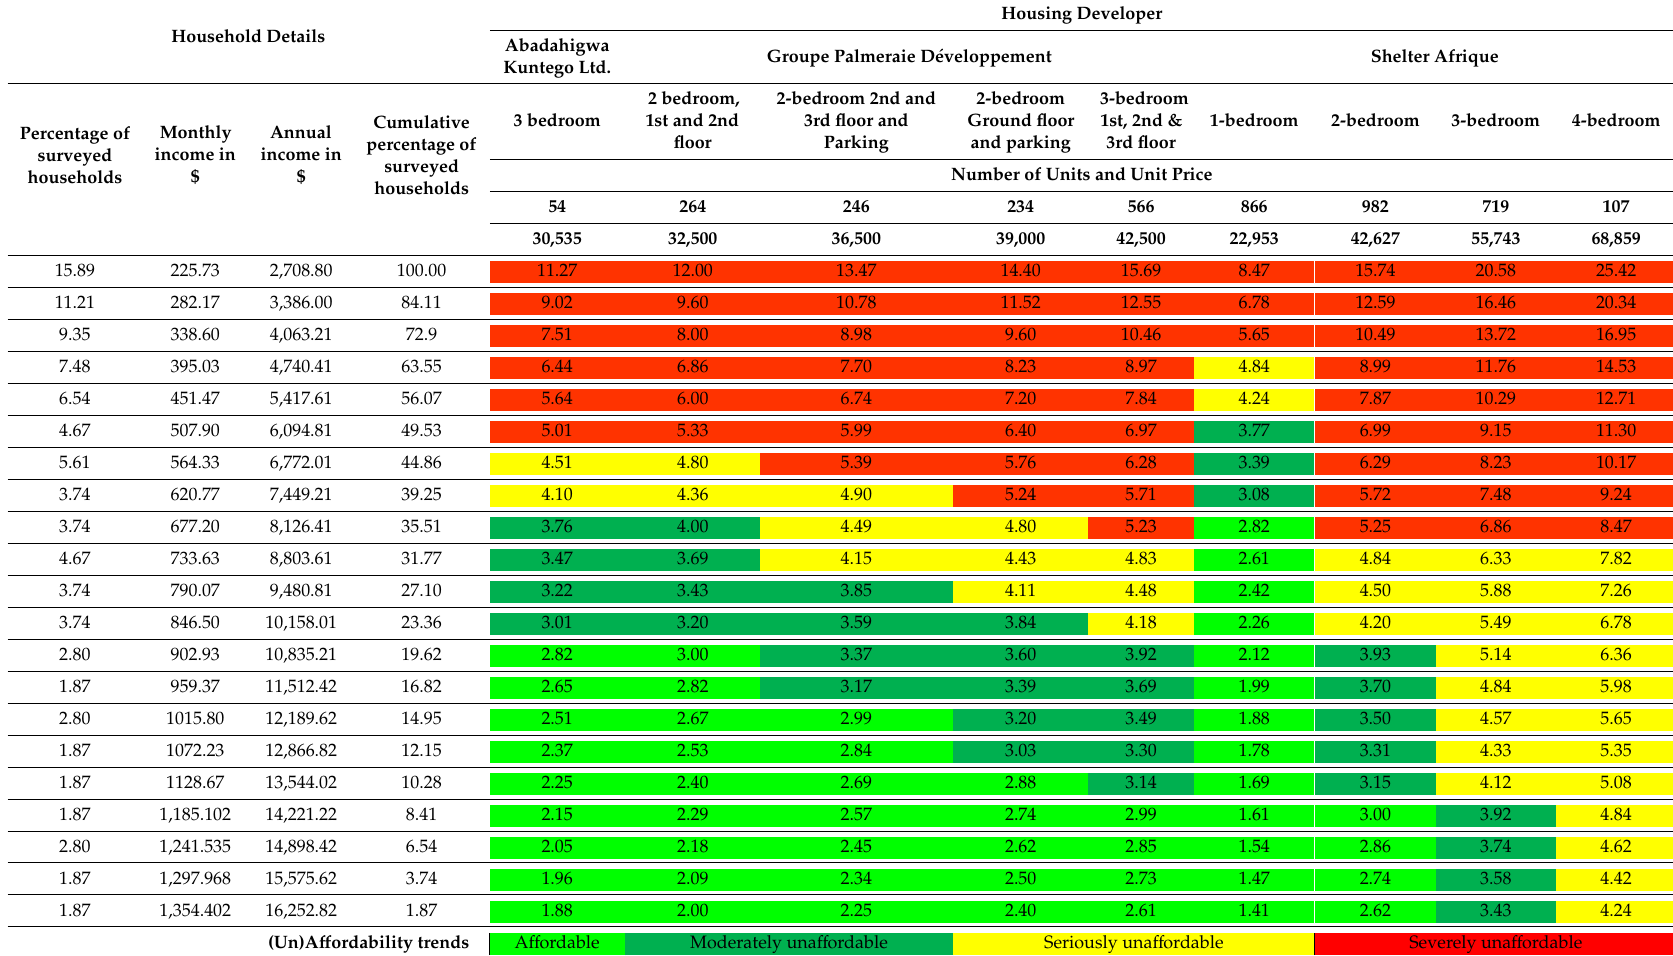
Table 5. Housing a ff ordability indices based on housing price and gross annual household income. Data source: Field survey (July–September, 2018 and January–March, 2019) and review of housing price lists held by real estate